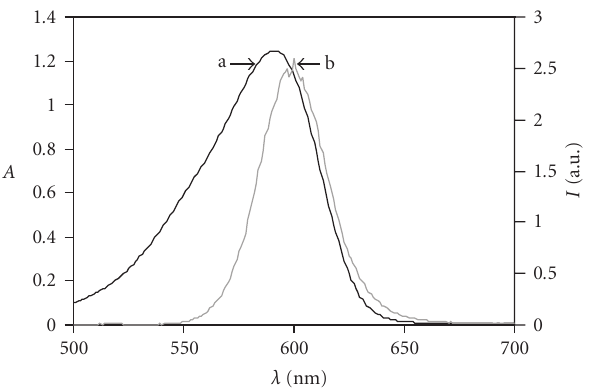
Figure 3: Absorption spectrum (a) of BODIPY-ATP (30 μ M) and emission spectrum (b) of CdSe-ZnS core-shell QDs (0.1 μ M) and His 6 -PDK1( Δ PH) in borate bu ff er (pH = 7.4, T = 20 ◦ C, λ EX = 442 nm).